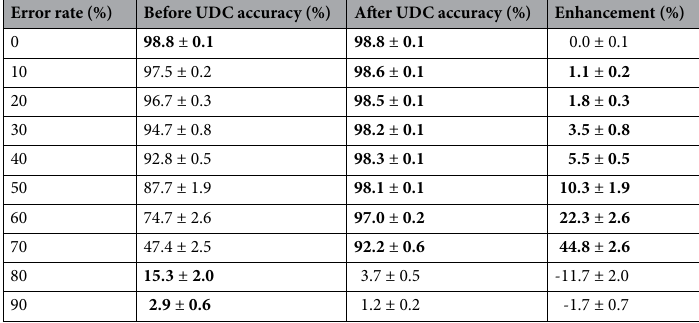
Table 2. Results from a single round of UDC applied to various incorrect label levels. The bold font draws attention to whether the ’Before UDC’ value or the ’After UDC’ value is the greater, for eachscenario, so that it is easy for the reader to judge which rows there was an improvement, and which rows there was a decrease. Incorrect labels are distributed evenly across all four classes: airplanes, boats, motorcycles, and trucks. UDC is robust to label error rates up to 70%, where a 44.8% gain in AI performance is achieved after a single round of